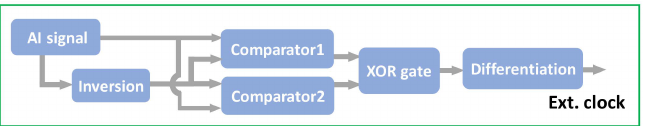
Figure 1. Circuit scheme of the zero-crossing detection for the auxiliary interferometer (AI) signal.